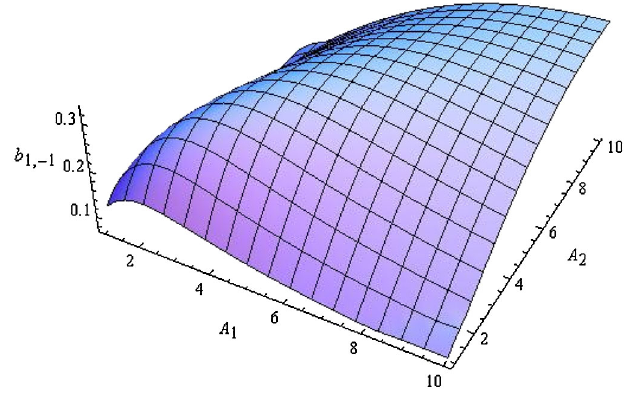
FIG. 2. (Color) The maximized bunching factor b 1 ; (cid:2) 1 as a function of the modulation amplitudes A 1 and A 2